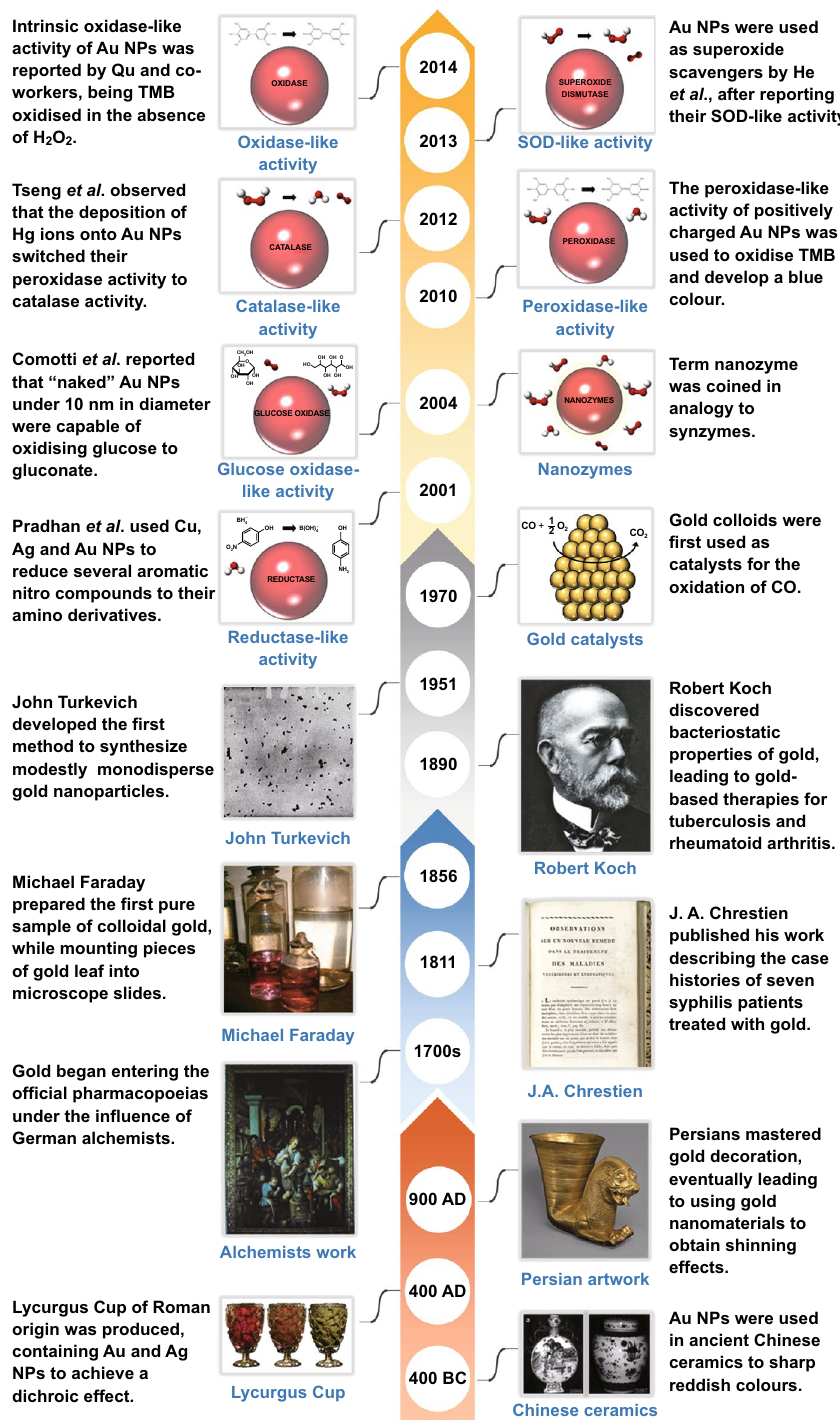
Fig. 1 Timeline highlighting relevant historical events that contributed to the development and implementation of gold nanoparticles. Ancient examples are shown before the arrow break, mostly related to the use of AuNPs as an ornament material, whereas biomedical implications are described after the break point. These include John Turkevich’s experiments [9], the first report on the use of gold colloids as catalysts [65] or the first time the term “nanozyme” was used [76]. The yellow arrow shows the years when each nanozyme activity was first reported for gold nanoparticles (reductase [74]‑, glucose oxidase [69]‑, peroxidase [71]‑, catalase [73]‑, SOD [72]‑ and oxidase [68]‑like